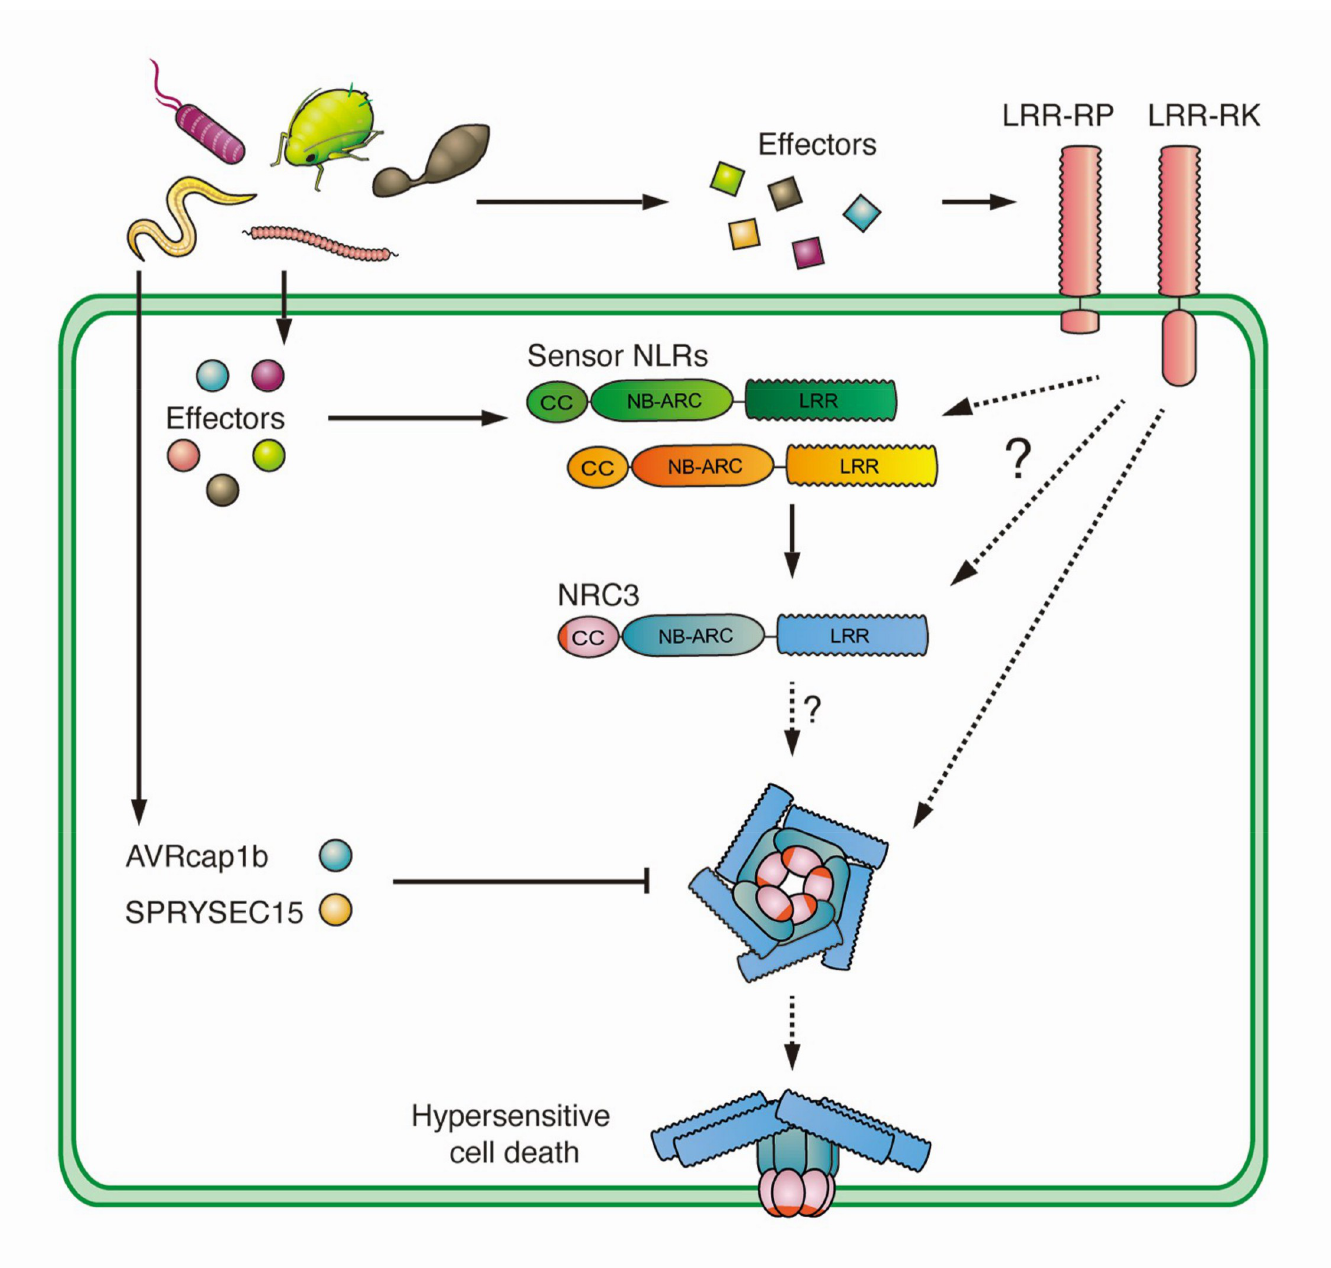
Fig 6. Hypersensitive cell death triggered by activation of cell-surface immune receptors requires the NRC network in Solanaceae. Recognition of apoplastic effectors and translocated intracellular effectors by cell-surface leucine-rich repeat receptor proteins and intracellular NRC-type sensor-NLRs, respectively, results in NRC3-mediated hypersensitive cell death. This cell death requires an intact α 1 helix of NRC3 indicating the possible formation of an activated NRC3 resistosome. Divergent pathogen effectors converge on this node to suppress both NLR triggered as well as cell-surface receptor triggered immune recognition. seems likely that NRC3 is only required for full activation of the subset of cell surface receptors that can trigger hypersensitive cell death. Since NRCs are transcriptionally upregulated upon activation of Cf-4, FLS2 and other cell surface immune receptors [38] it may be that Cf-4 acti- vation results in transcriptional upregulation of NRC3 in a NRC-independent manner, to